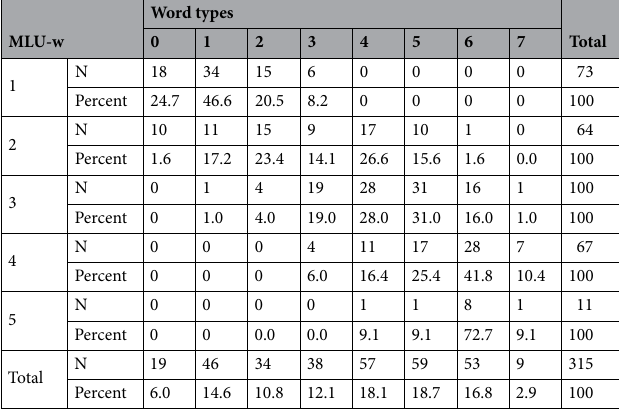
Table 6. Contingency tables of Subject pronoun according to MLU-w.